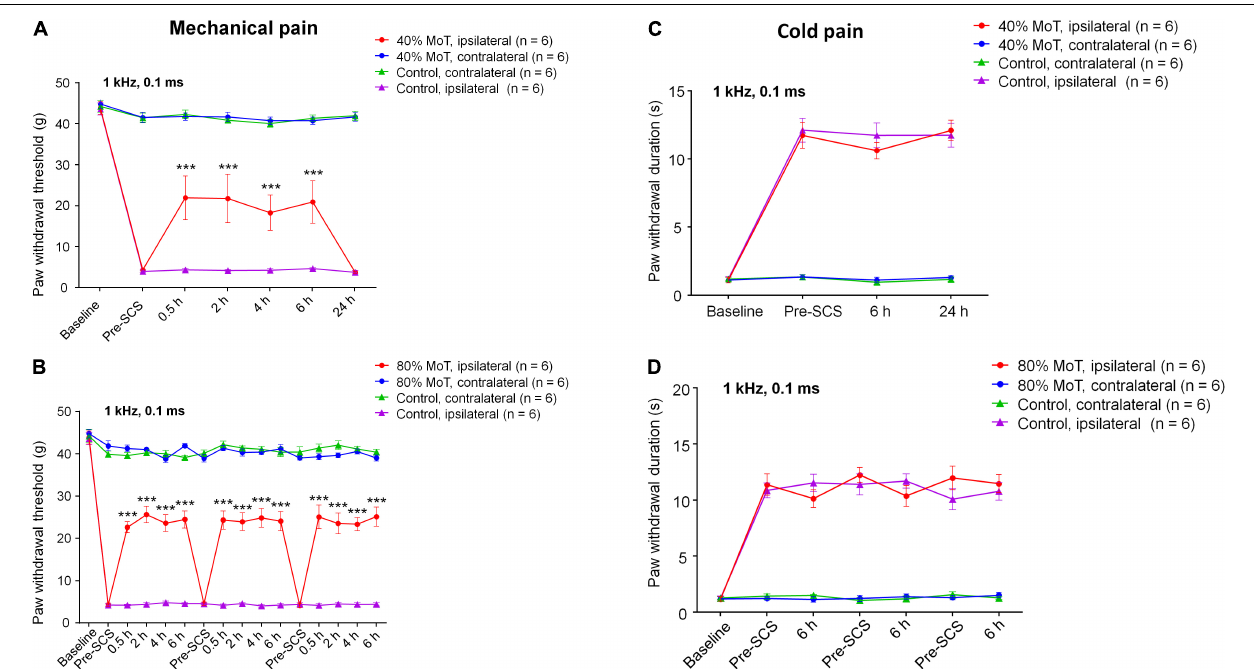
FIGURE 2 | SCS at 1 kHz Hz attenuates nerve injury-induced mechanical allodynia in SNI rats. (A,C) Effects of 1 kHz SCS (6 h per day) at 40% MoT on mechanical allodynia measured by paw withdrawal threshold (PWT) using electronic von Frey testing at 0 (Pre-SCS), 0.5, 2, 4, 6, and 24 h (A) and cold allodynia in acetone testing at 0 (Pre-SCS), 6, and 24 h (C) . (B,D) Effects of 1 kHz SCS at 80% MoT on mechanical allodynia in von Frey testing (PWT, B ) and cold allodynia in acetone testing (D) . *** P < 0.001, compared with Pre-SCS baseline. Two-way ANOVA, followed by Bonferroni post hoc test. Sample sizes (number of rats per group) are indicated in each panel. SCS was conducted approximately 2 weeks after SNI. Note the SCS has no effects on cold allodynia. Ipsilateral side = injury side. Control animals had SNI surgery and electrode implantation without SCS (SCS-OFF).